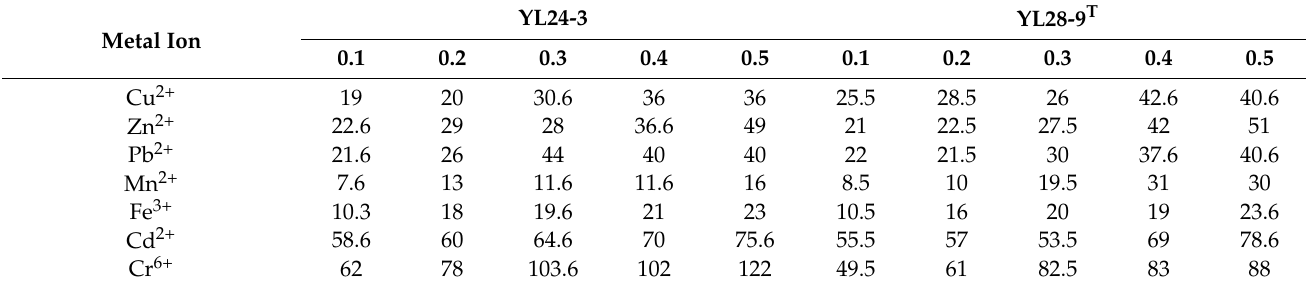
Table 3. The inhibition zone diameter (mm) of the strains under different concentrations (M) of heavy metals. Metal Ion